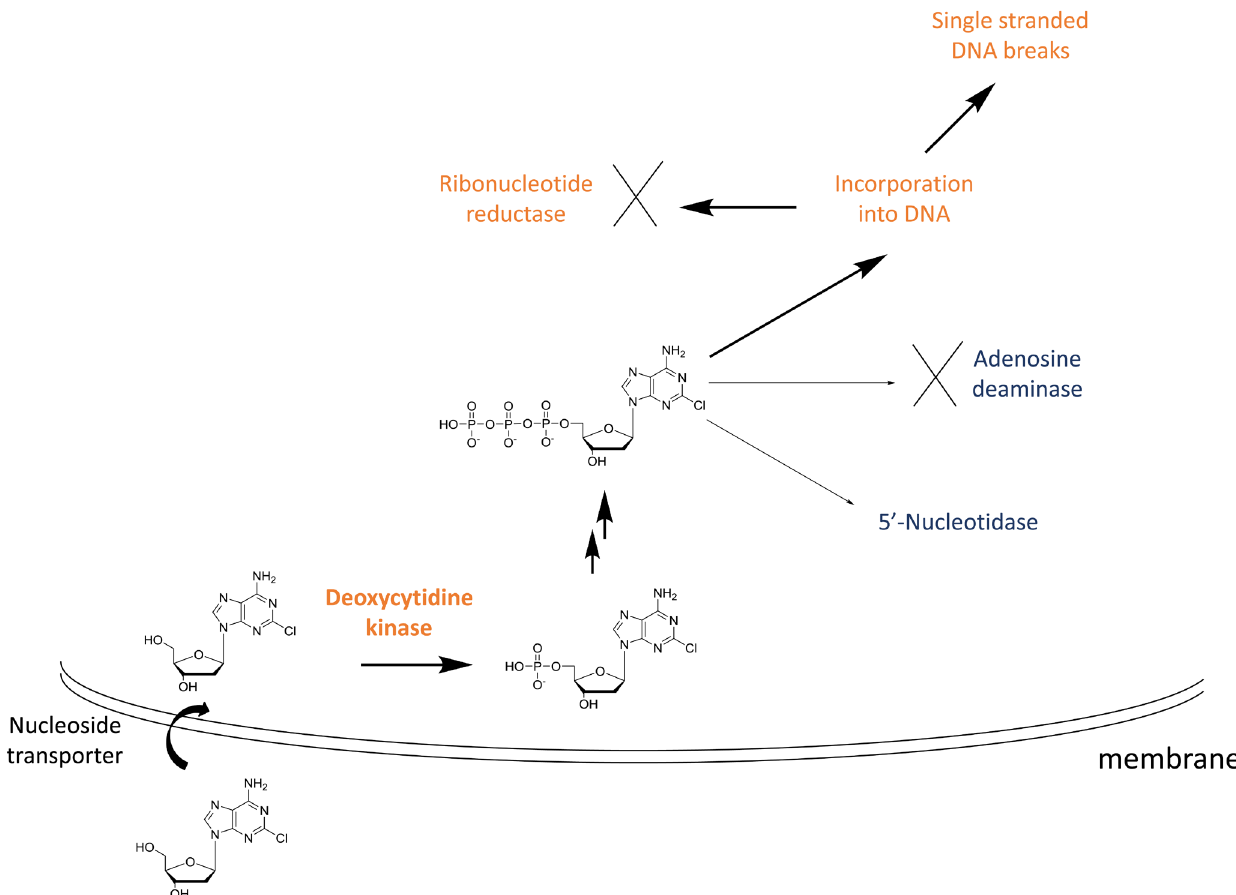
Figure 2. Mechanism of action of cladribine. Cladribine is taken up into cells by nucleoside transporters and then is phosphorylated to the mono-phosphate (the rate-limiting step) by deoxycytidine kinase, highly expressed in lymphocytes. Subsequent phosphorylation steps produce the active species, the triphosphate. The triphosphate cannot be efficiently degraded by adenosine deaminase, and 5 ′ -nucleotidase has low expression in lymphocytes. This leads to high levels of the cladribine triphosphate, which is toxic to cells by a number of mechanisms, including incorporation into DNA leading to single-stranded